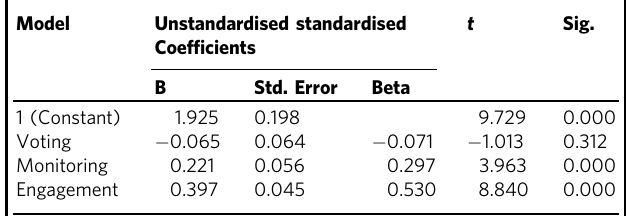
Table 4 Coef fi cients a of agency con fl